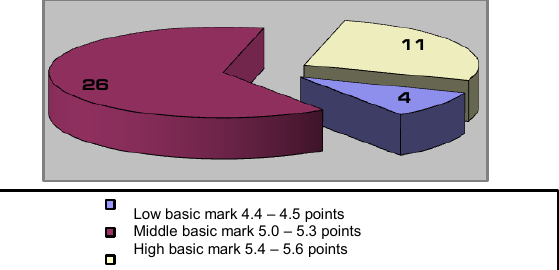
Fig.1. Determination of technical fitness of female gymnasts, considering points for complexity